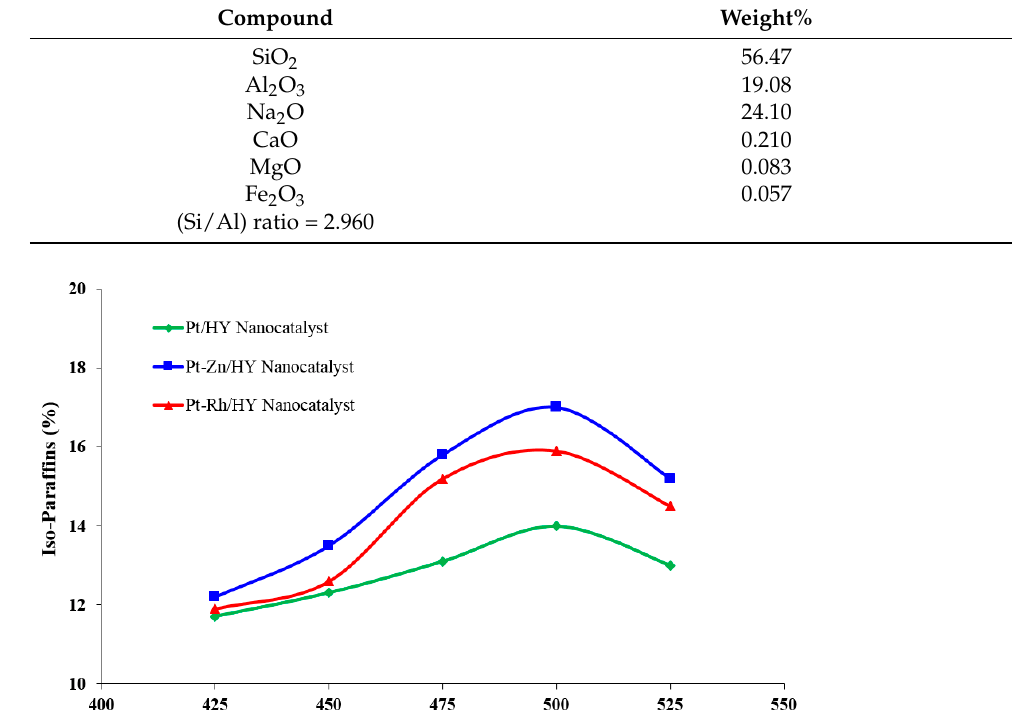
Figure 3. XRD and SEM results of the synthesized nano-size Y-zeolite.